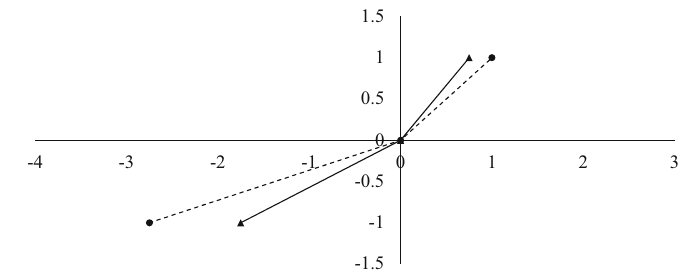
Fig. 7 Average intention change for certain (dashed line with dots) and uncertain (straight line with triangles)